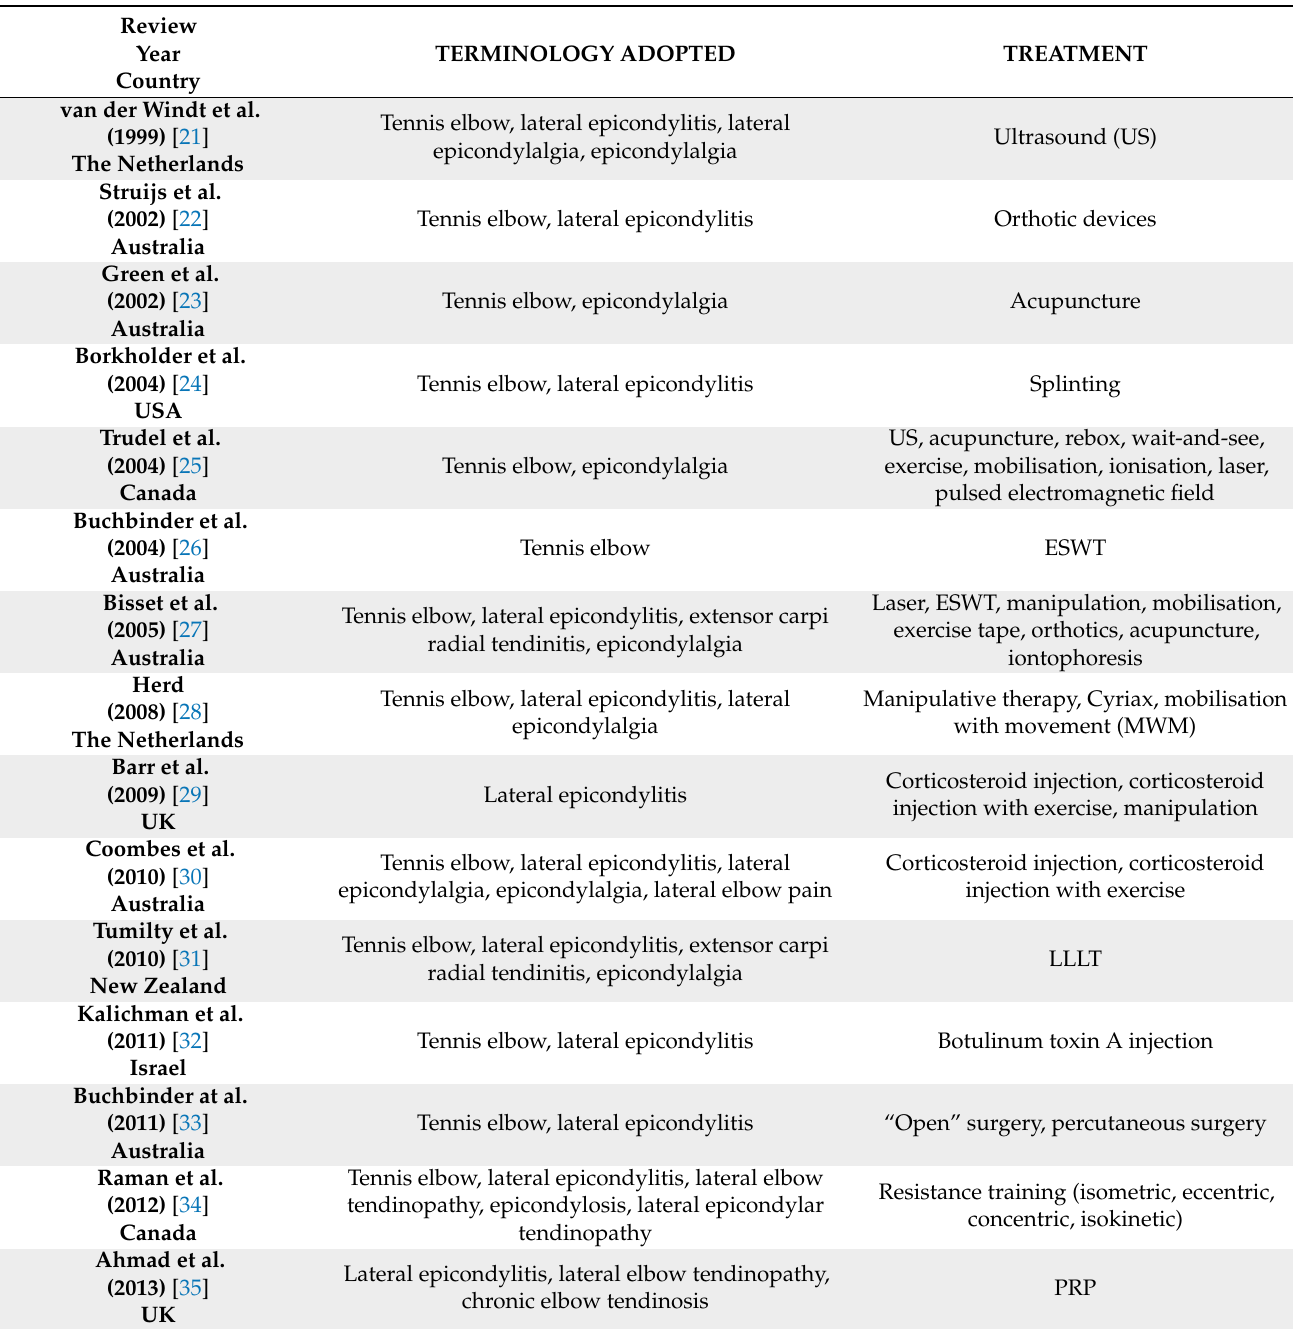
Table 2. Treatments and terminology used to define